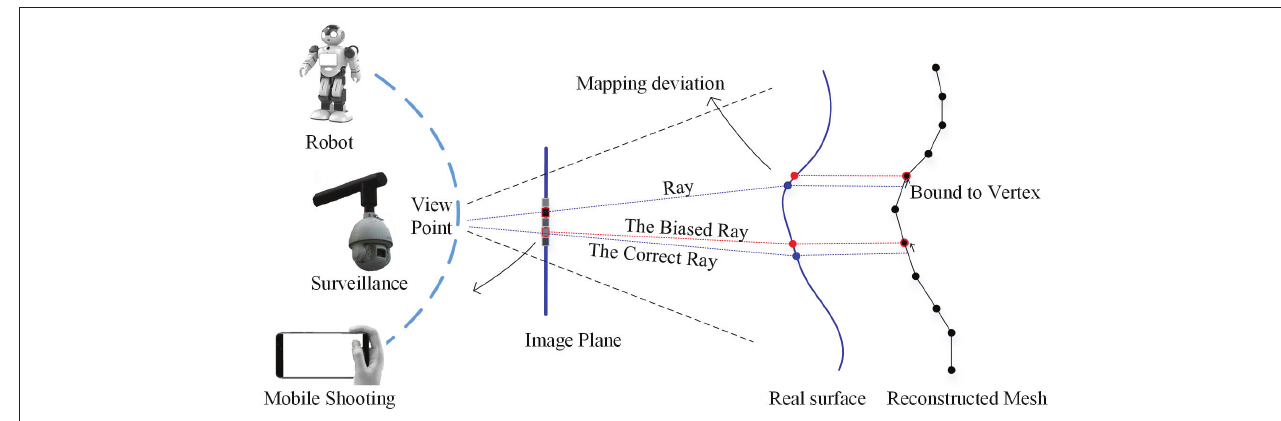
FIGURE 1 | Geometric optics of BP (i.e., back projection) imaging on two types of surfaces: the correct ray lines go through the blue points on the true shape, while the biased ones go through red points on the mesh shape because the cross point between a ray and mesh is bounded to vertex. The difference between red point and the blue point is referred to local mapping